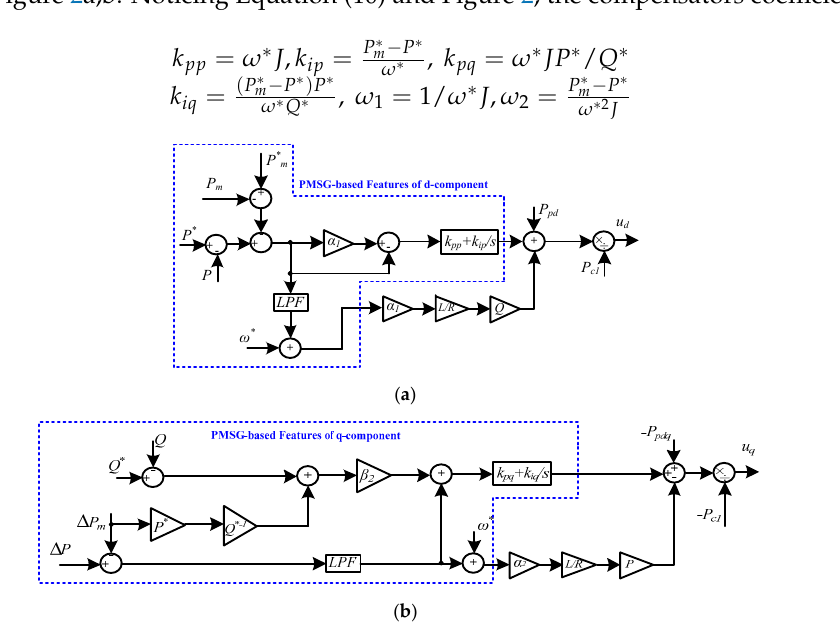
Figure 2. The proposed control technique, ( a ) the d -component, and ( b ) the q -component. PMSG: permanent magnet synchronous generator; LPF: low pass filter.